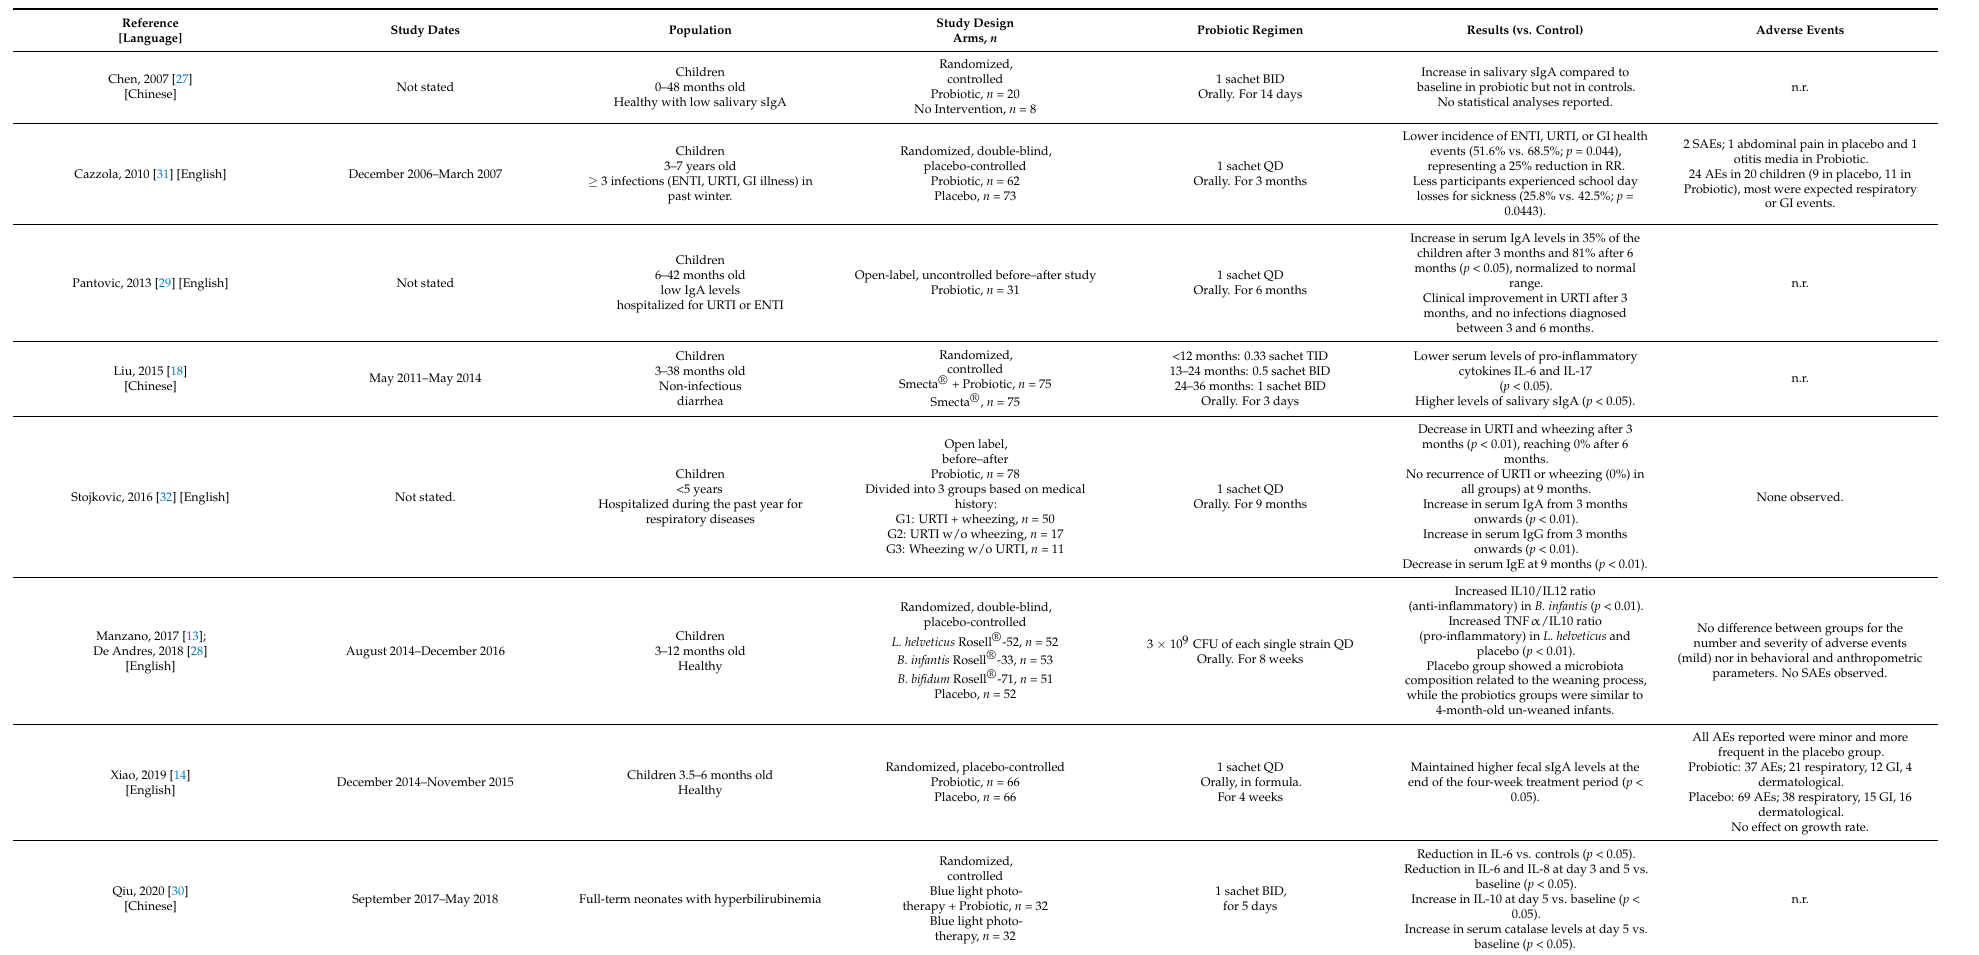
Table 4. Details of studies on immunity and natural